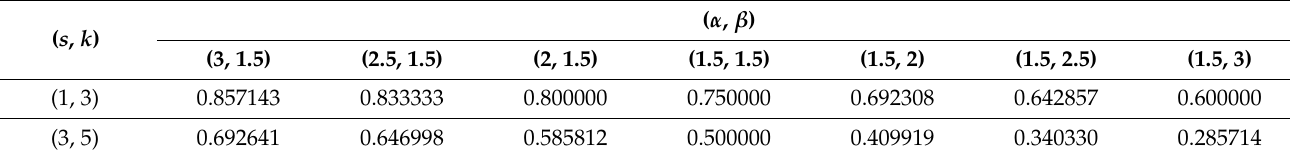
Table 1. True Values of R s , k for various combination of parameters.